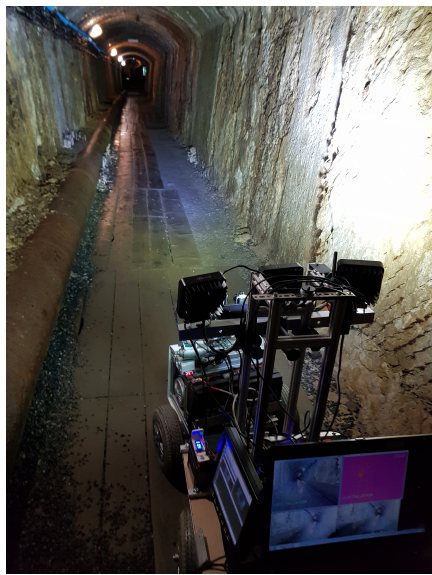
Figure 4. Robot equipped with sensory system and